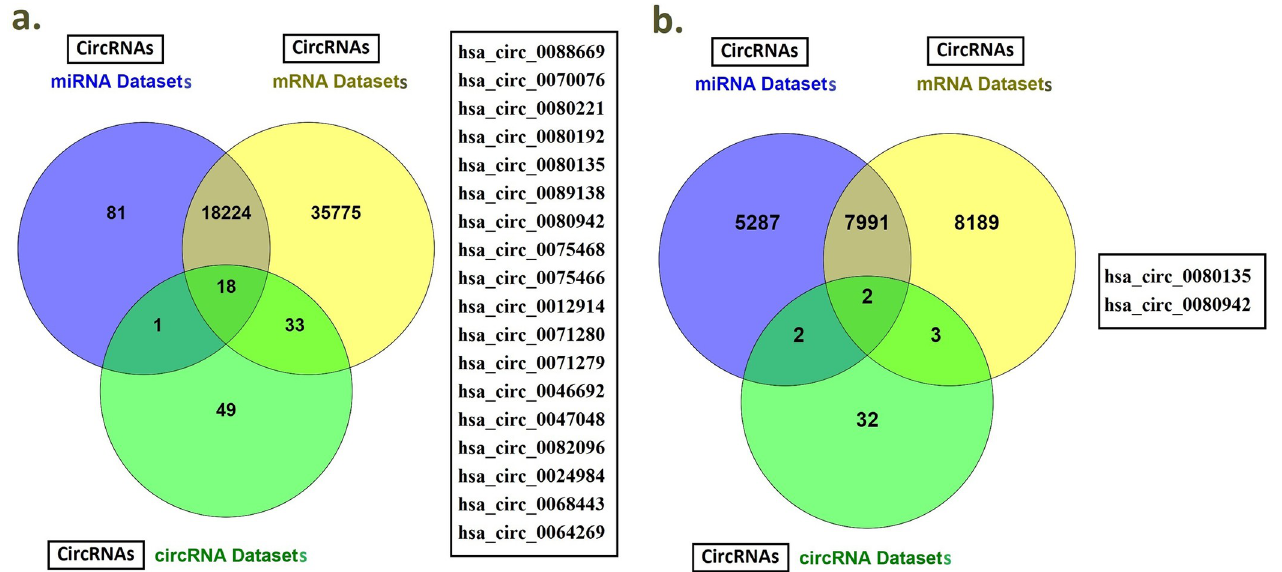
Fig 3. Venn diagram of overlapped differentially expressed circRNAs among circRNAs of circRNA datasets, miRNA datasets and mRNA datasets. a) Overlapped differentially expressed circRNAs among circRNAs of circRNA datasets, miRNA datasets and mRNA datasets (whole genes). b) Overlapped differentially expressed circRNAs among circRNAs of circRNA datasets, miRNA datasets and mRNA datasets (cytokine storm related